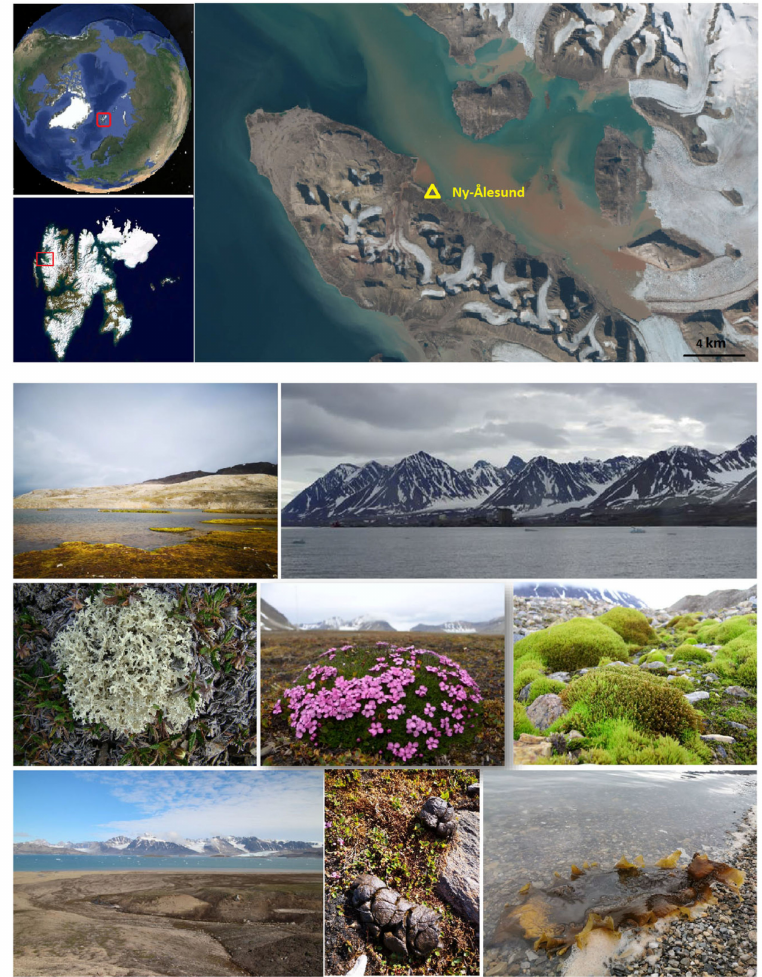
Figure 1. The location of the sampling site and views of various habitats (e.g., soil, lichen, vascular plant, moss, freshwater, seawater, dung, and marine alga) in the Ny-Ålesund Region (Svalbard, High